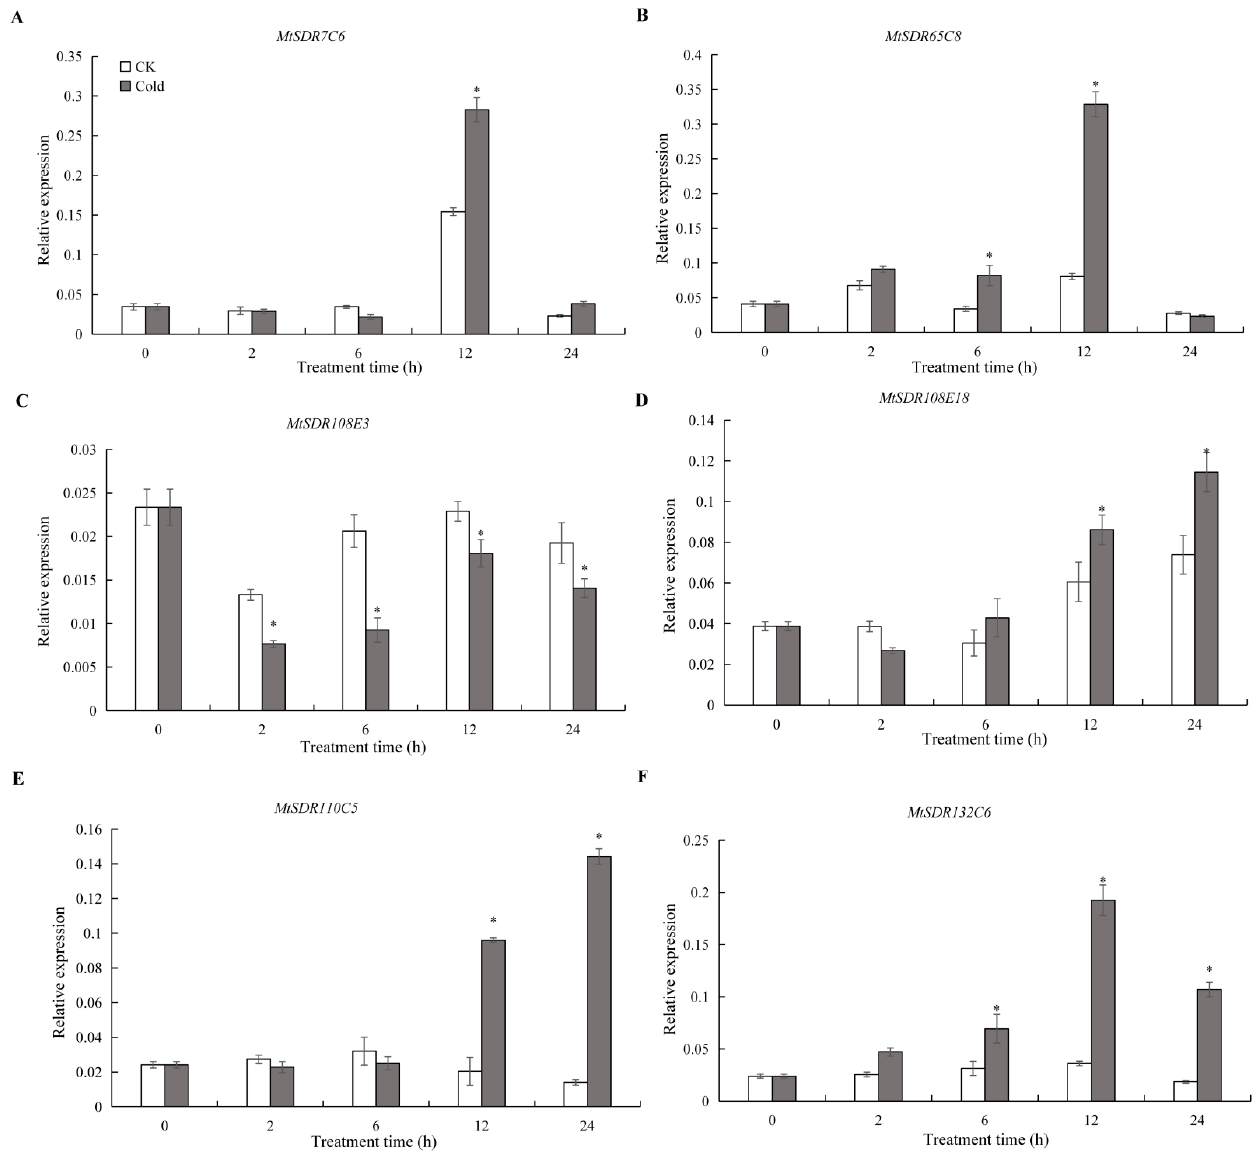
Figure 8. Relative expression of MtSDR7C6 ( A ), SDR65C8 ( B ), SDR108E3 ( C ), SDR108E18 ( D ), SDR110C15 ( E ) , and SDR132C6 ( F ) in response to cold treatment. Four-week-old seedlings were placed in a growth chamber at 4 °C for 0, 2, 6, 12, and 24 h. Mean values and standard errors were calculated from three biological replicates. * indicates significant difference between cold treatment and control using one-way ANOVA at p ≤ 0.05.